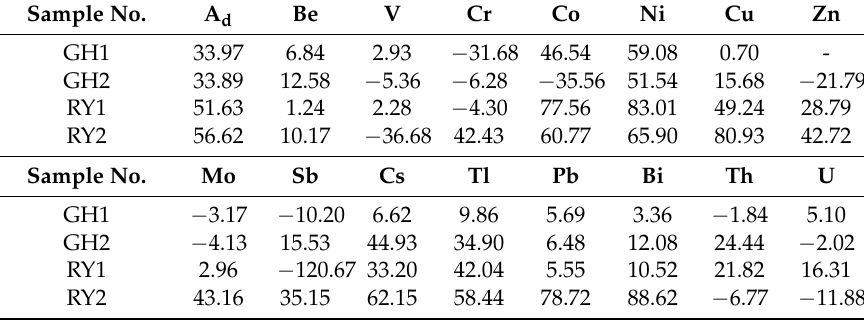
Table 6. The removability of toxic elements in cleaned coal via flotation